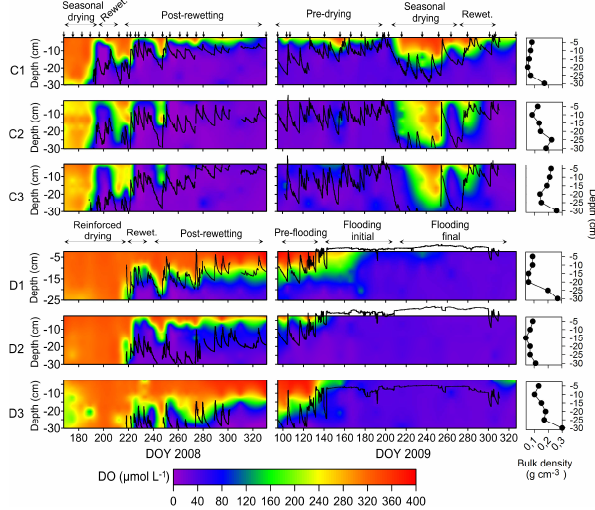
Fig. 2. Dissolved oxygen (DO) concentrations in fen peat profiles during changes in water table (solid black line, not shown below 30 or 25cm depth). Sampling frequency is indicated on top with arrows. Different hydrological periods and the depth distribution of bulk density are also shown (Estop-Aragon´es et al., 2012). Copy- right 2012 American Geophysical Union. Modified by permission of American Geophysical Union.